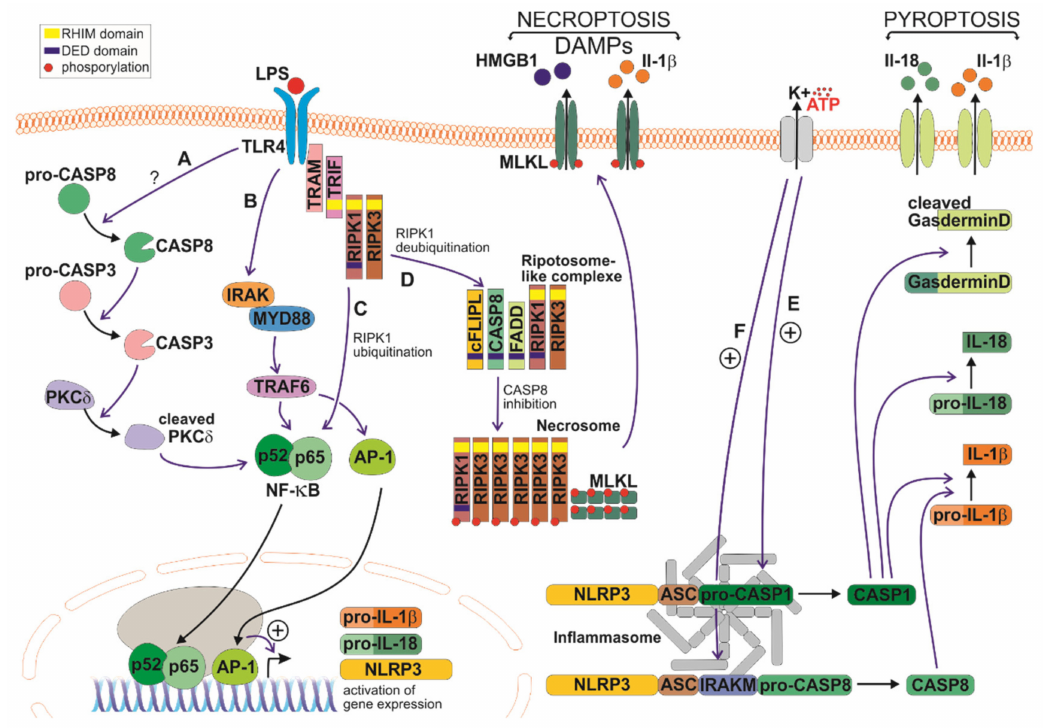
Figure 1. TLR4 signaling pathways activated in microglia during neuroinflammation. ( A )